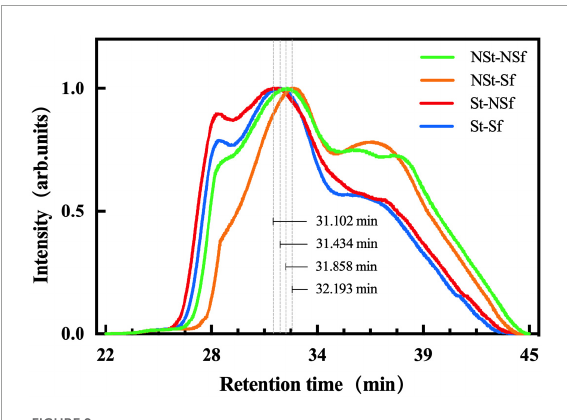
FIGURE9 Molecular weight and size distribution of Gastrodia elata starch (with normalized intensity).